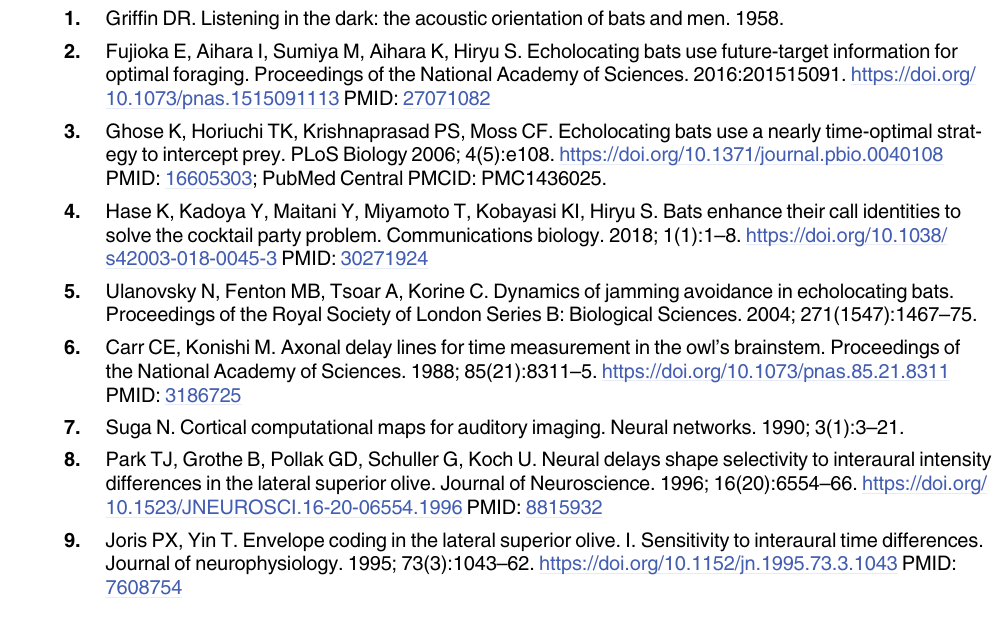
S1 Fig. Examples of the direction detection performance without ear motion using super- vised machine learning. The ear motion condition was chosen as [ c l ; r Blue ‘x’ markers indicate test data ( θ , φ ) and red ‘+’ markers indicate output data ( θ φ guess ). Black lines denote the error lines connecting points ( θ , φ ) and ( θ guess , φ guess ). Each detection error line tends to stretch vertically, indicating that the elevation angle is difficult to detect while the azimuth angle can be accurately